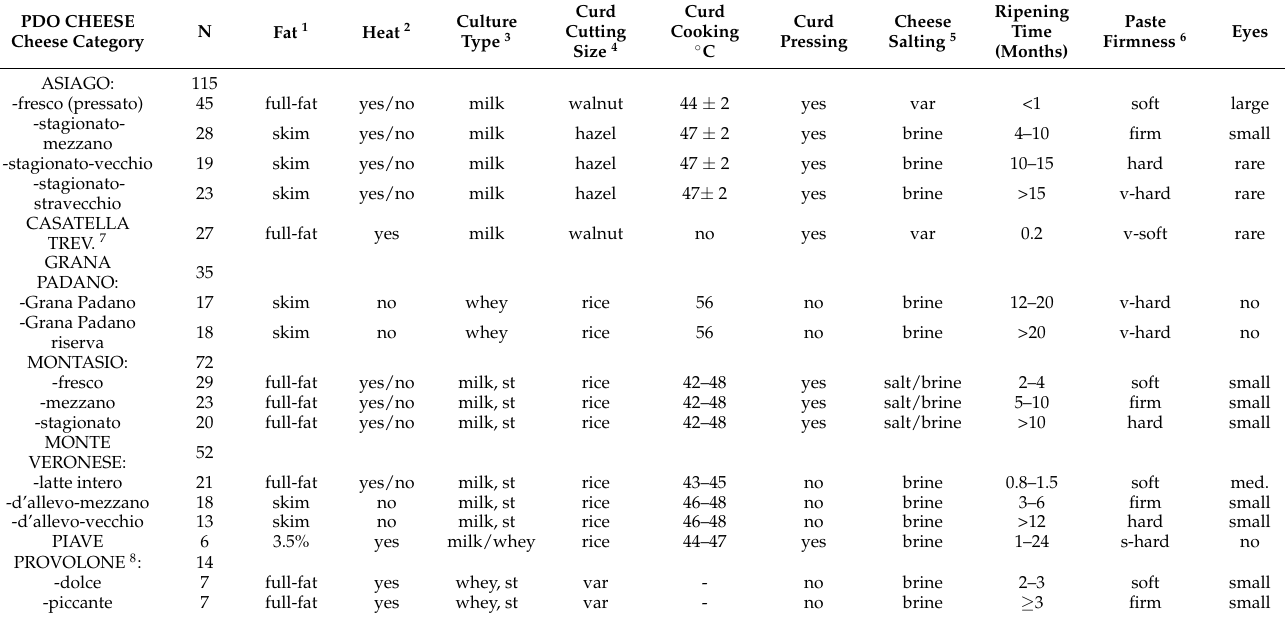
Table 1. Main characteristics and cheese-making techniques of 16 cheese categories under the 7 protected designation of origin denominations (PDO, 321 cheeses) according to their production